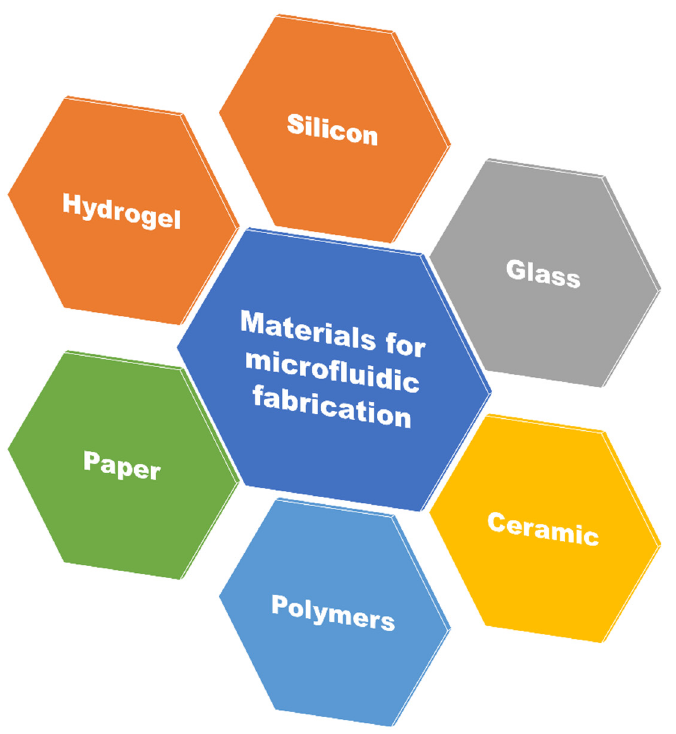
Figure 5. Scheme showing different classes of materials that were used for microfluidic fabrication.